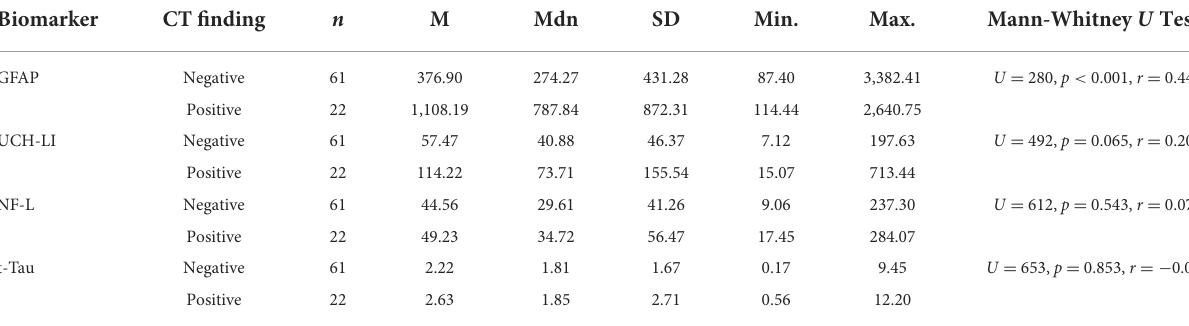
TABLE 3 Descriptive statistics for the biomarkers by